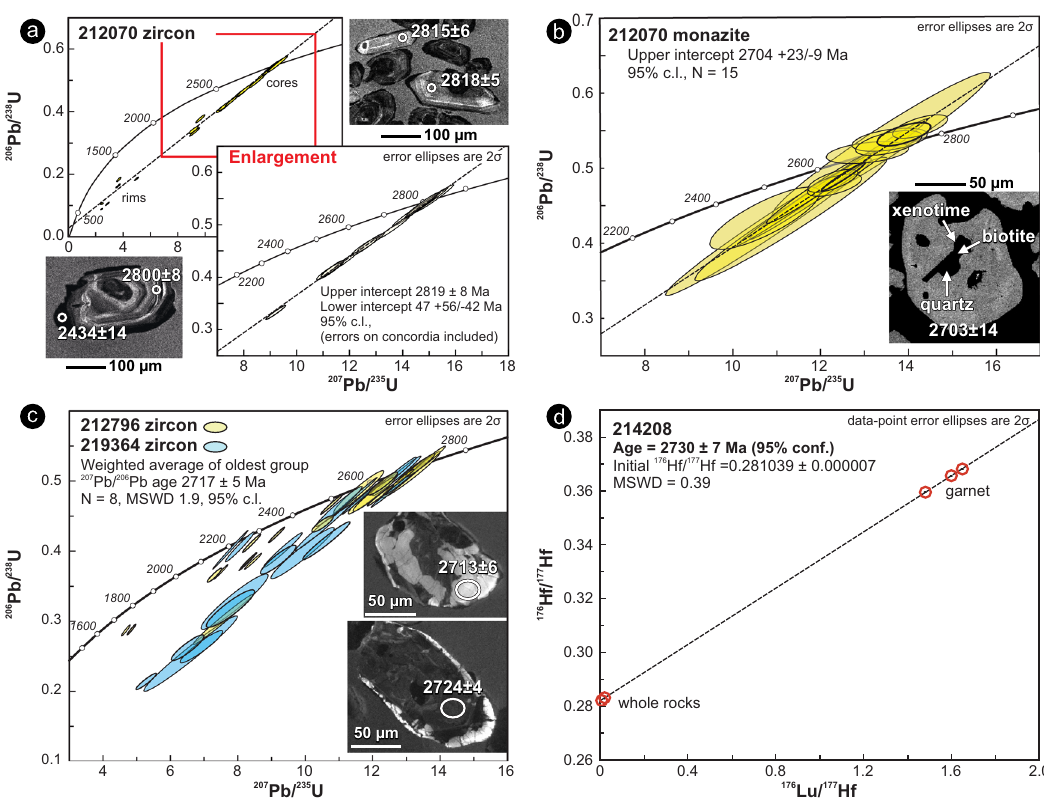
Fig. 6 | Geochronology results for zircon, monazite and garnet. a – c Concordia diagrams of U-Pb analyses of zircon and monazite. The inset in each panel shows representative cathodoluminescence (CL; zircon) and back-scattered electron (BSE; monazite) images of analysedgrains with the spotlocation (white circle) and